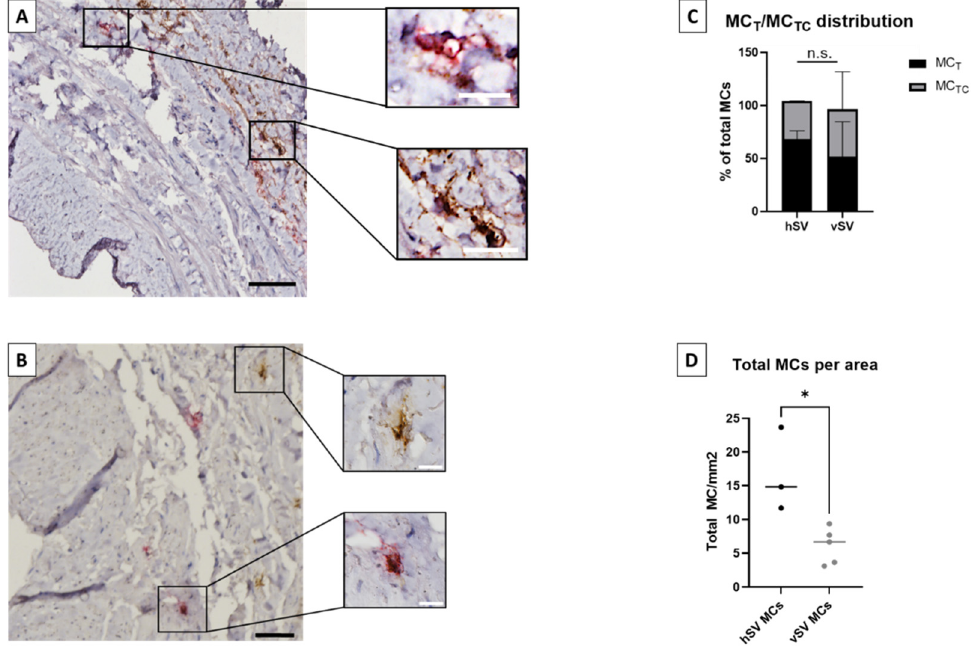
Figure 1. Localization and distribution of mast cells (MCs) in vein. ( A , B ): Illustration of MC localization in human saphenous vein: several 4 µ m sections of healthy saphenous vein (hSV, ( A )) or varicose saphenous vein (vSV, ( B )) were stained with double horseradish peroxidase staining. Red staining: MC T . Brown staining: MC TC . Black bar: 100 µm, white bar: 10 µm. ( C ): Distribution of MC T and MC TC in both hSV ( n = 3) and vSV ( n = 5). ( D ): Overview of total MC counted per mm 2 in hSV ( n = 3) and vSV ( n = 5). * p < 0.05, n.s.: non-significant p -value.